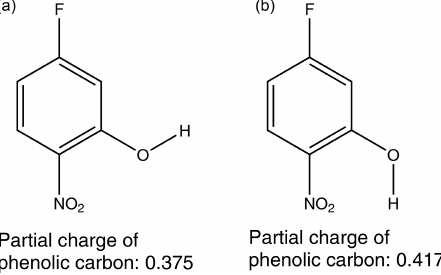
Figure 4. The orientation of the OH group can impact the partial charge of the phenolic